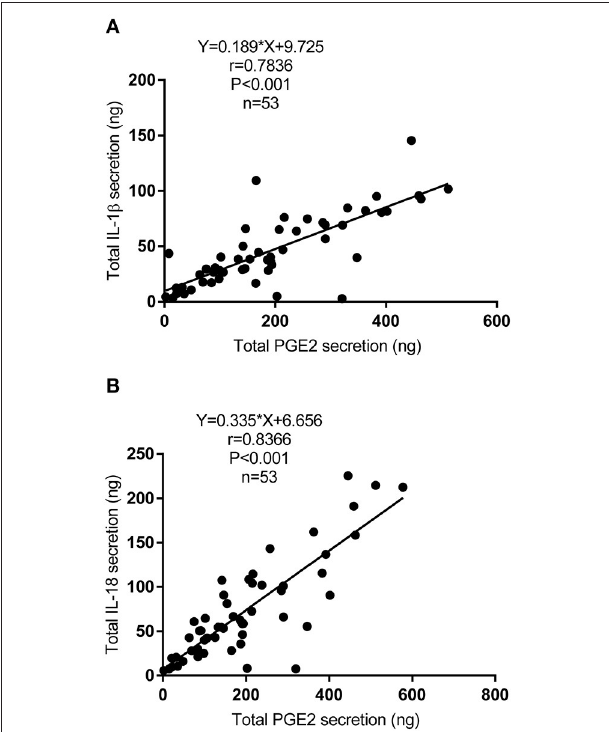
FIGURE 7 | Correlation between the secretion of PGE2 and IL-1 β or IL-18 in PD fluid. (A) Bivariate correlation analysis between the total secretion of PGE2 and IL-1 β in incident PD patients’ dialysate (Spearman’s rank correlation analysis, n = 53). (B) Bivariate correlation analysis between the total secretion of PGE2 and IL-18 in incident PD patients’ dialysate (Spearman’s rank correlation analysis, n =